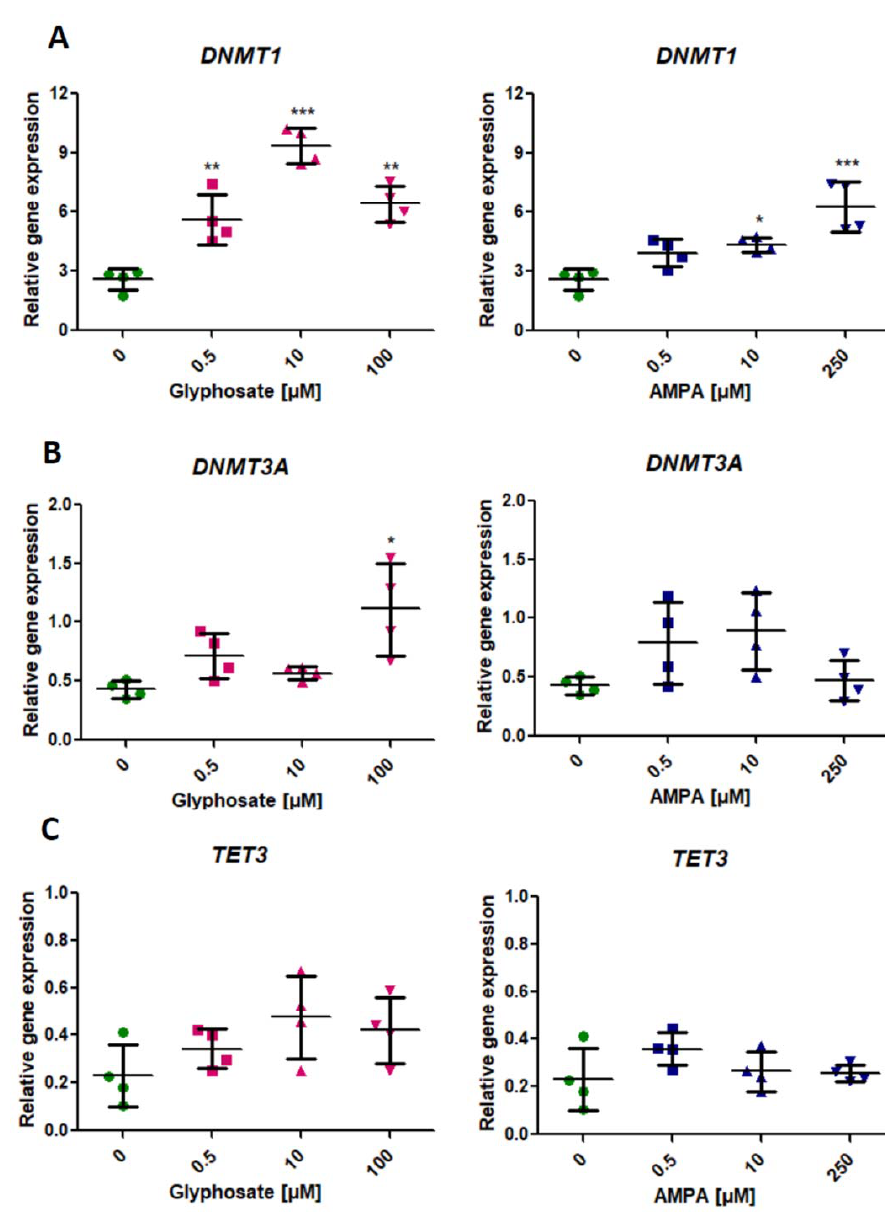
Figure 1. Expression of genes involved in DNA methylation— DNMT1 ( A ), DNMT3A ( B ), and DNA demethylation— TET3 ( C ) process in human PBMCs incubated with glyphosate (0.5–100 µ M) and AMPA (0.5–250 µ M) for 24 h. Mean ± SD was calculated for four individual experiments (four blood donors). Statistically different from control at * p < 0.05; ** p < 0.01 and *** p < 0.001. Statistical analysis was conducted using one-way ANOVA and a posteriori Tukey